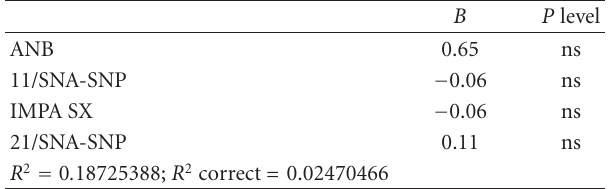
Table 6: Group 1 (25 subjects): linear regression results for OJ- l; no independent variable was found to be statistically significant in the multivariate linear regression model. The systematic error calculated via Student’s t -test for paired data yielded a significance level of 0.05; ns: non significant (Student’s t -test). B